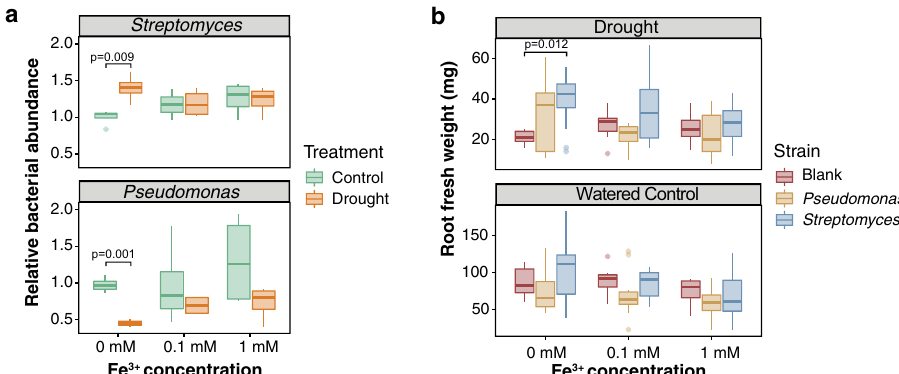
Fig. 7 Exogenous iron disrupts Streptomyces enrichment and reverses plant growth promotion capacity. a Boxplot of the relative bacterial amount as measured using qPCR with lineage-speci fi c primers across control (green) and drought-treated (orange) root samples in both Streptomyces ceolicolor Sc1 (upper panel) and Pseudomonas syringae (bottom panel) strains across two levels of iron application and a mock control (0 mM Fe3 + ). Values are means ± SD ( n = 4) from four independent biological replicates. b Measurement of fresh root weight phenotypes upon application of two levels of Fe 3 + and a mock control (0 mM Fe 3 + ) causes a loss of root growth promoting phenotypes conferred by the Actinobacteria Streptomyces under drought (upper panel). No signi fi cant differences were observed under control conditions (lower panel). One-sided Tukey ’ s multiple-comparison tests were used for calculating the p values between different inoculations. Values are means ± SD ( n = 7) from seven independent biological replicates. For both ( a ), ( b ), one- sided Tukey ’ s multiple-comparison tests were used for calculating the p values between different inoculations. Box bounds indicate one quartile above and below the mean, while whiskers indicate one standard deviation above the